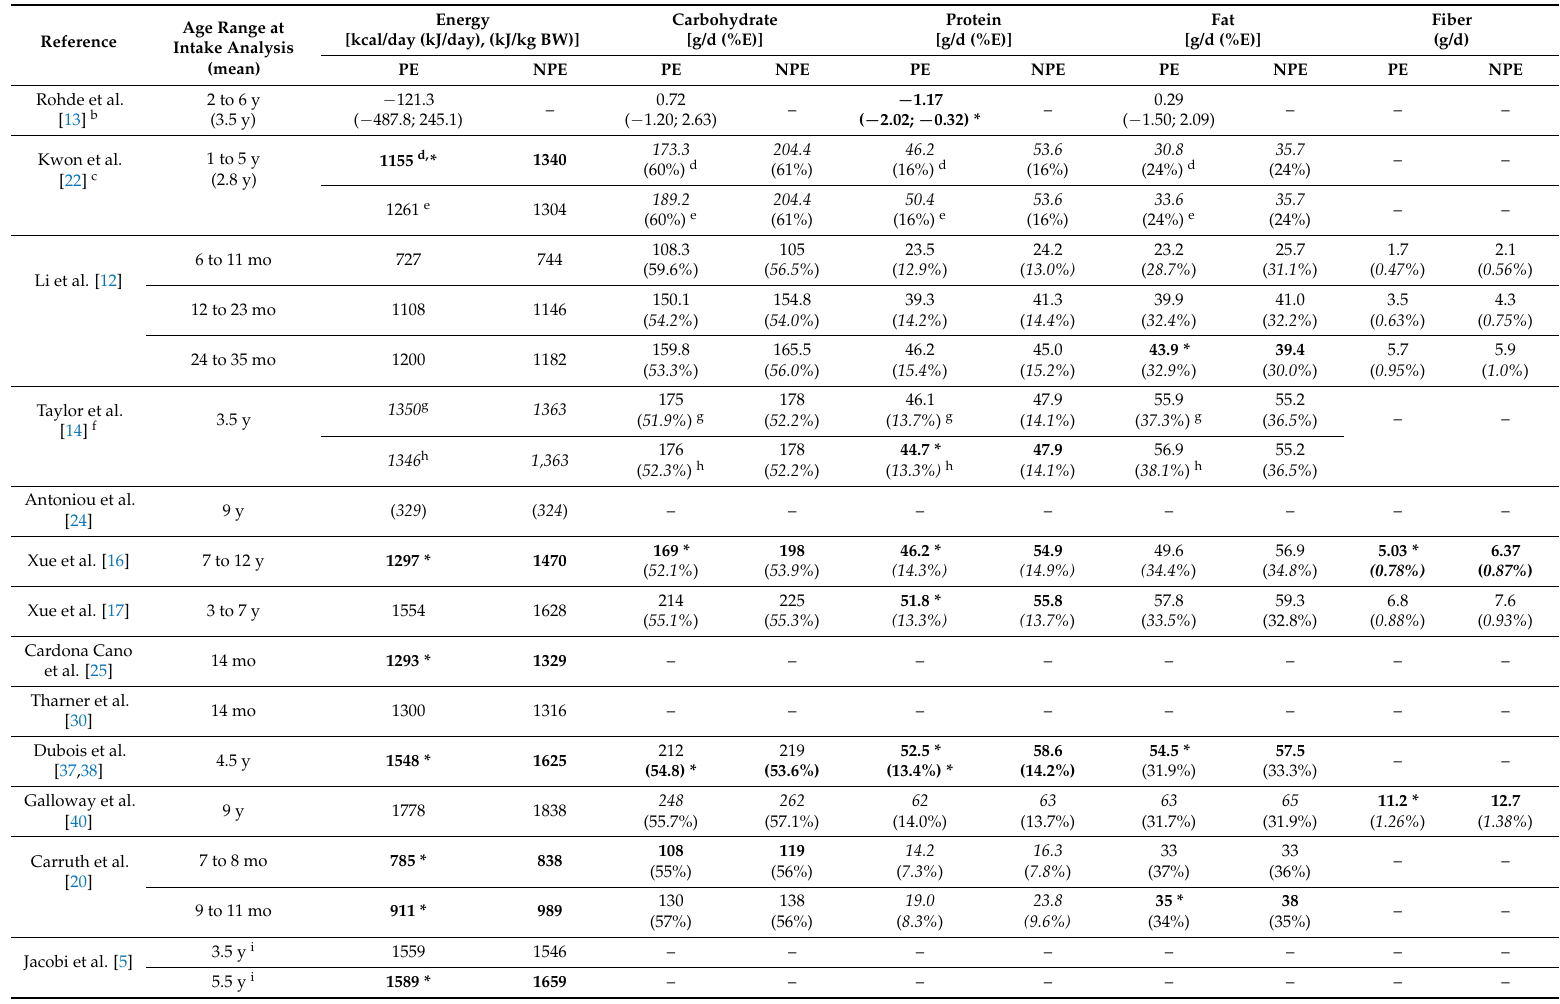
Table 5. Intakes of Energy and Macronutrients in PE and NPE a